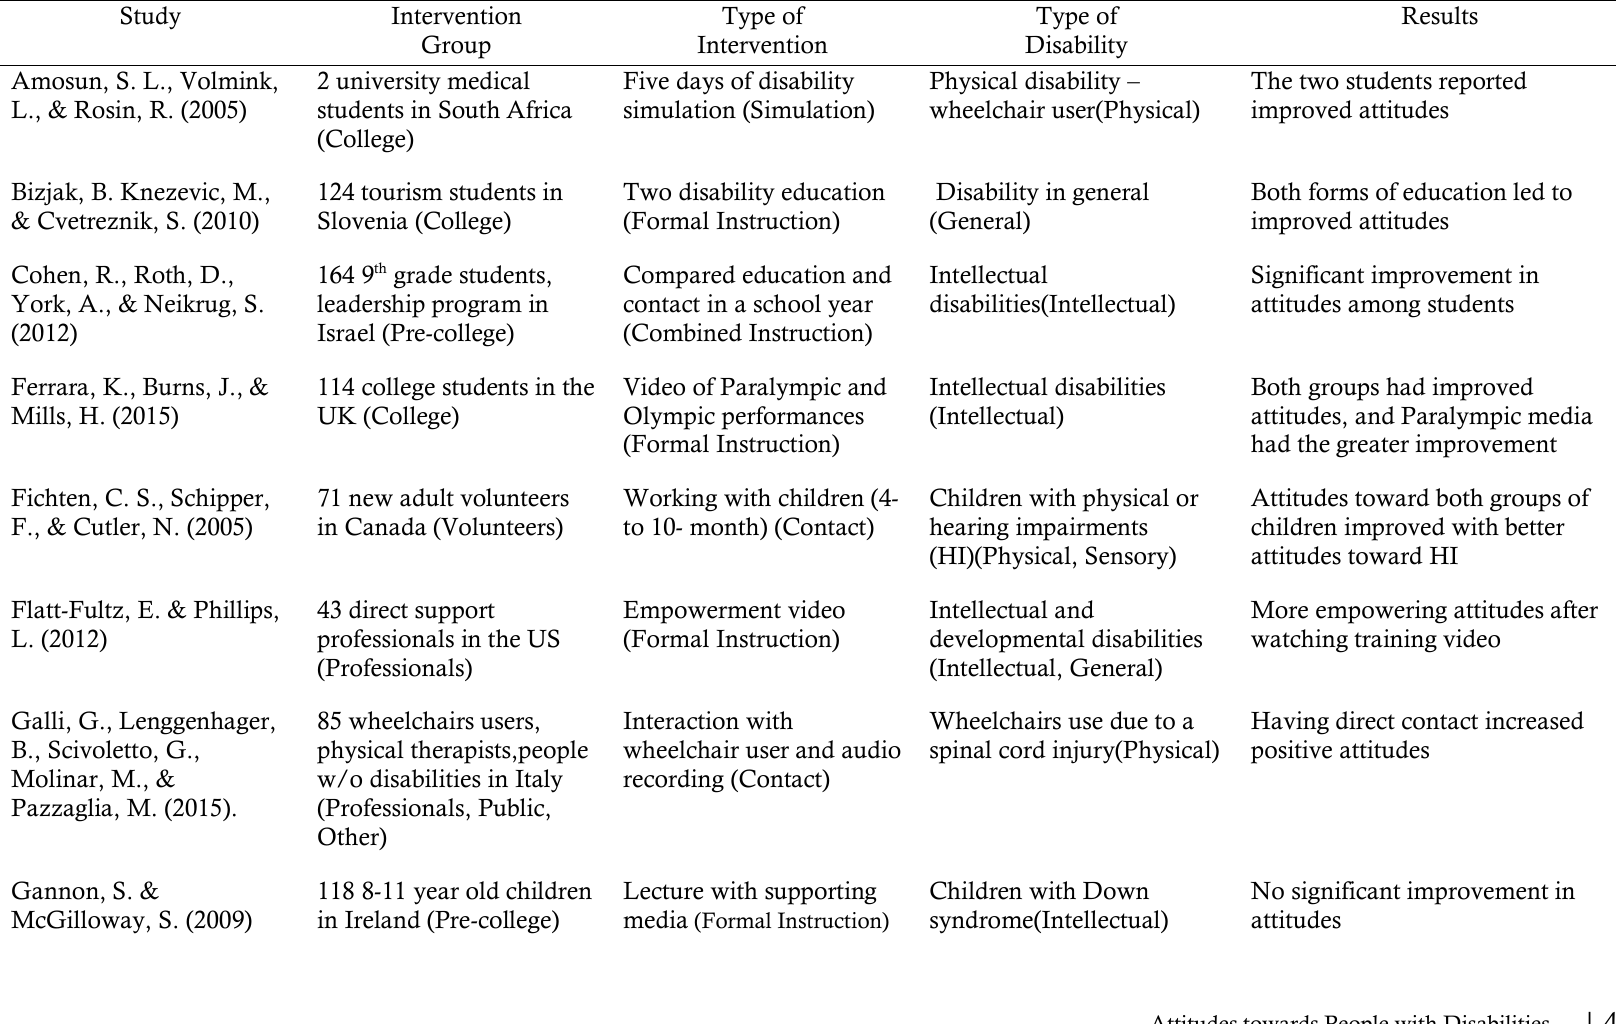
Table 1. Studies using interventions to change attitudes toward people with